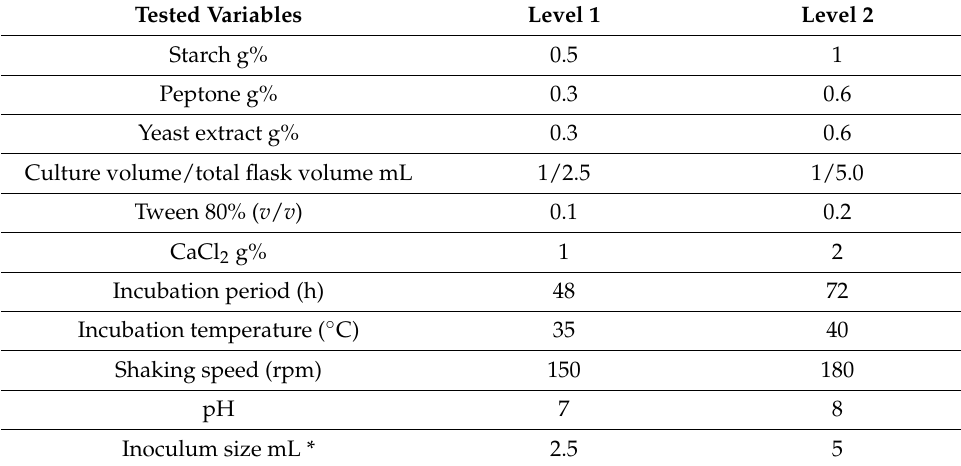
Table 1. Independent variables affecting the production of alpha-amylase by the MS009 isolate, and their levels in the Placket–Burman